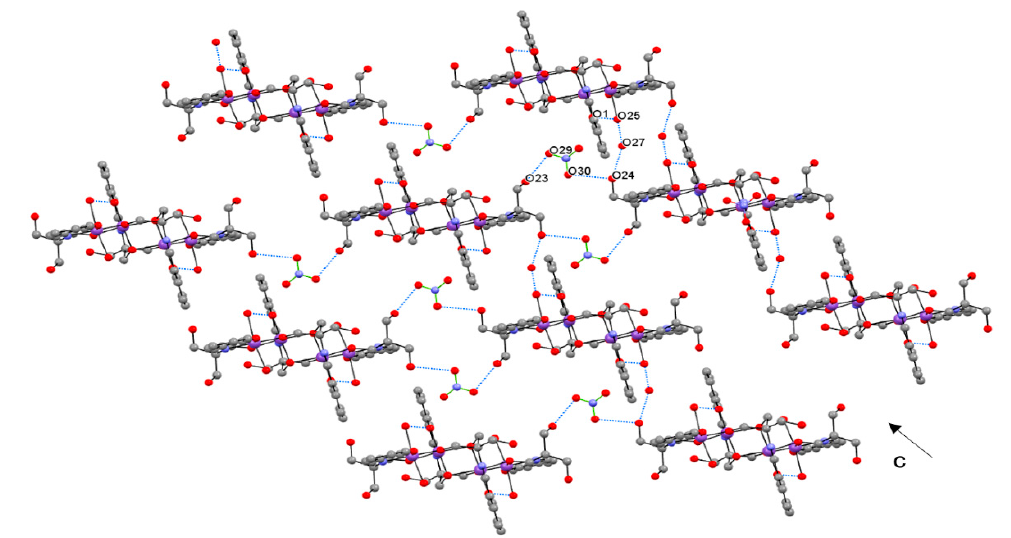
Figure 2. Zig-zag supramolecular pattern in the structure of 1 by hydrogen bridges along c axis.